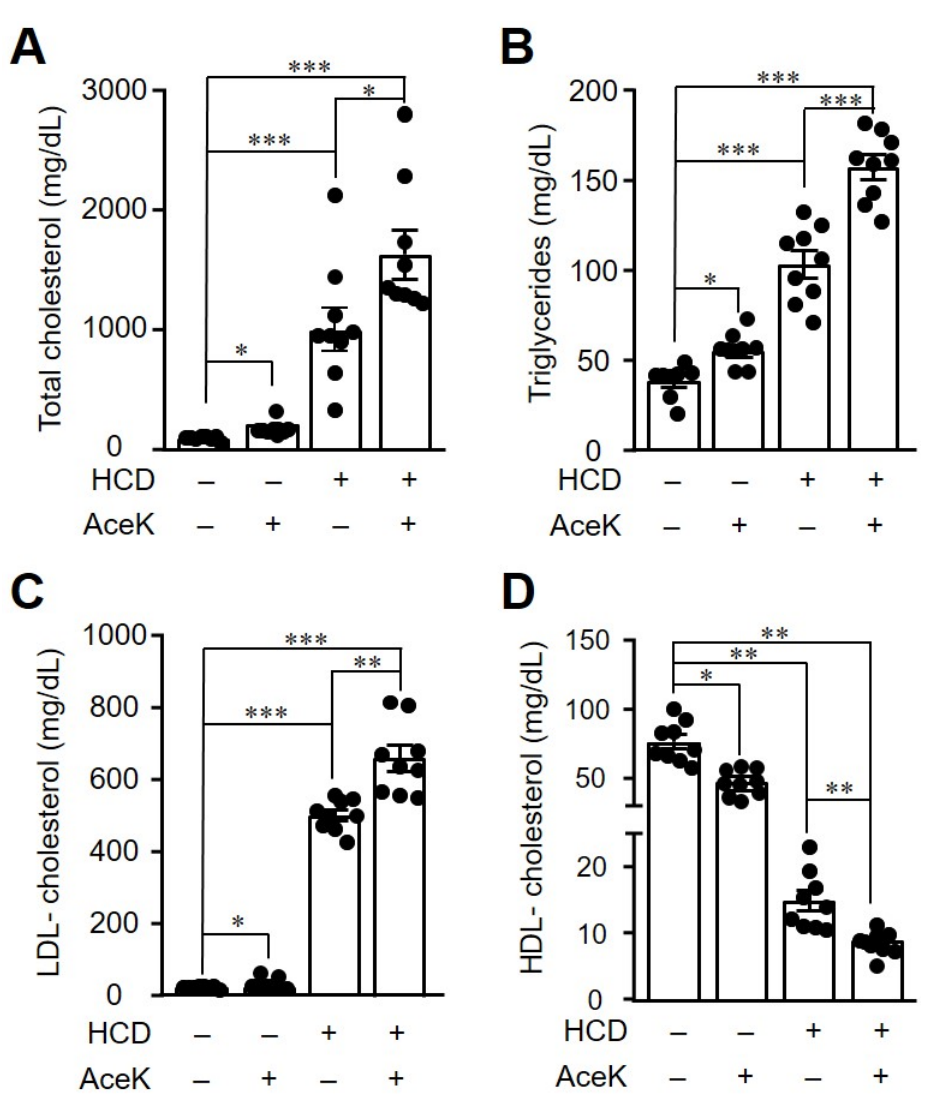
Figure 3. Administration of AceK worsened dyslipidemia in high cholesterol diet-fed ApoE − / − mice. The mice were fasted for 12 h and then blood samples were collected for the determination of lipid profiles. Plasma total cholesterol ( A ), triglyceride ( B ), low-density lipoprotein cholesterol (LDL-cholesterol) ( C ), and high-density lipoprotein cholesterol (HDL-cholesterol) ( D ) were determined using commercialized assay kits ( n = 9 per group of mice). * p < 0.05, ** p < 0.01, *** p < 0.001.